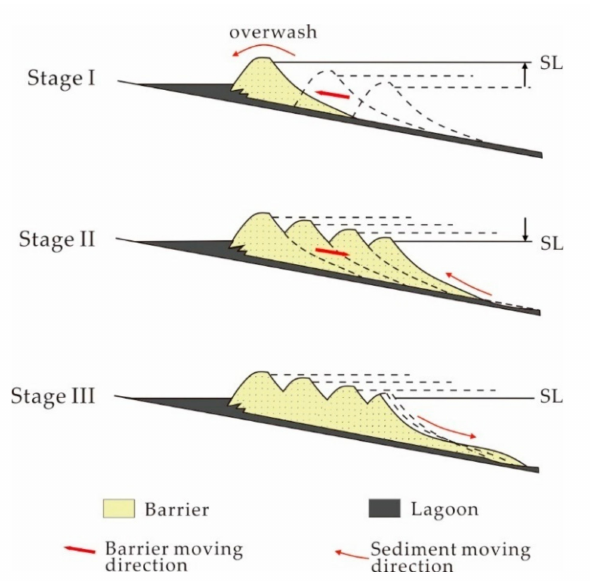
Figure 5. Three stages in the evolution of the barrier-lagoon coasts of the Dapeng